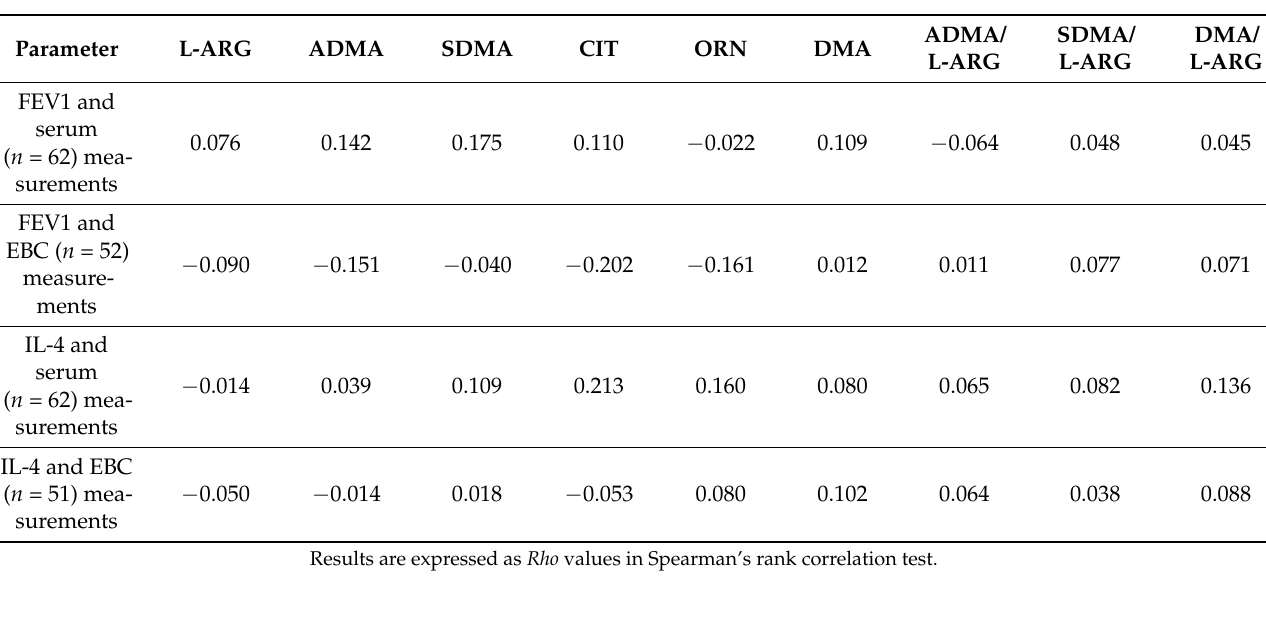
Table 6. Correlation of FEV1 and IL-4 in serum and EBC with L-ARG and its metabolites.